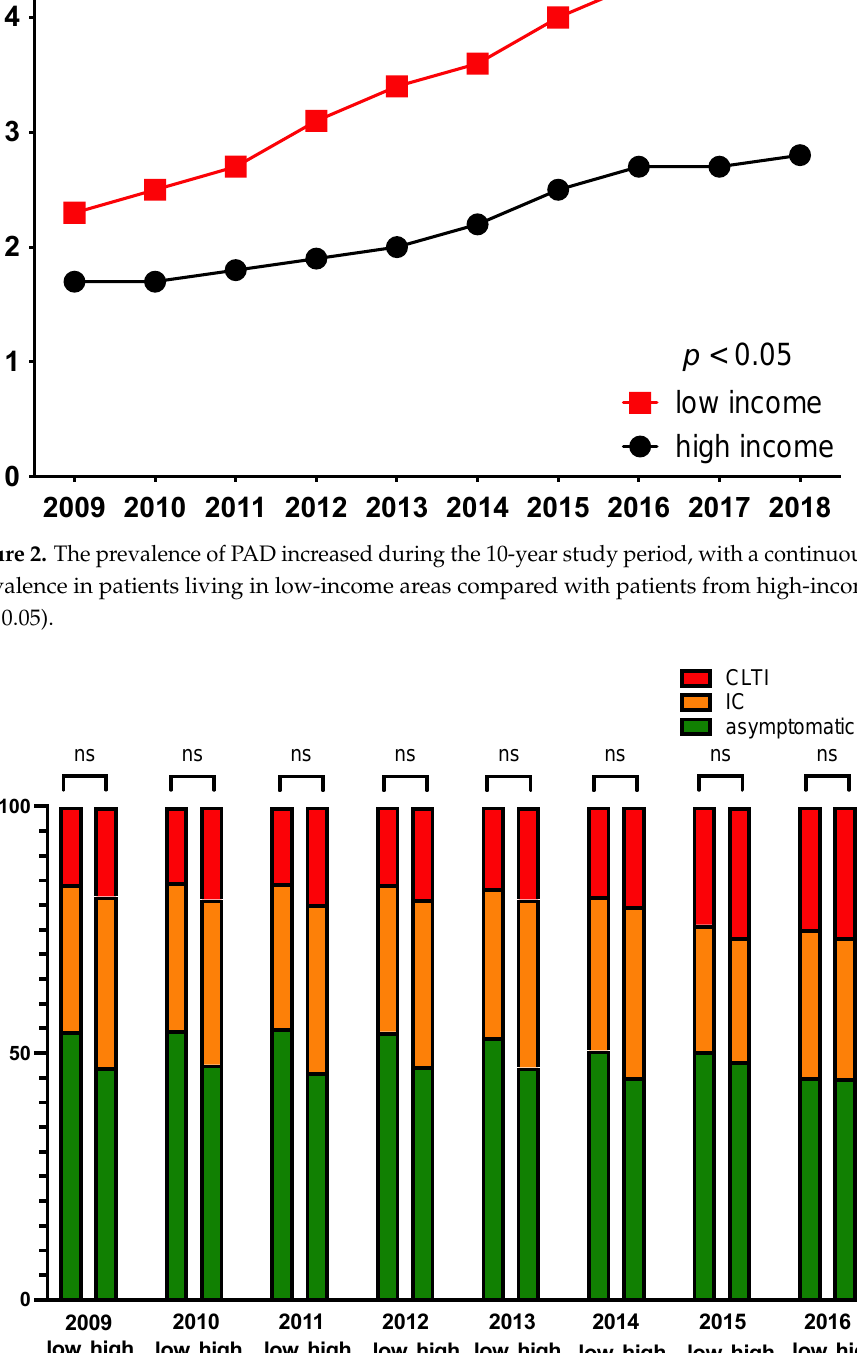
Figure 3. Peripheral artery disease stratified according to severity (asymptomatic, intermittent clau- dication (IC), critical limb-threatening ischemia (CLTI)). Severity of PAD did not differ between low- income and high-income areas (ns denotes not significant). High-income areas had higher outpatient vascular surgery and cardiology density during the study period, whereas the outpatient angiology density was higher in low- income areas (Figure 4).